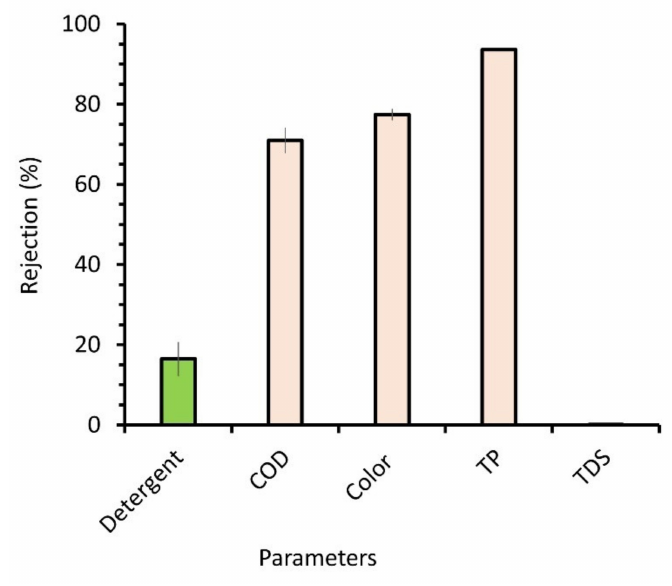
Figure 5. Rejection performance of laundry wastewater